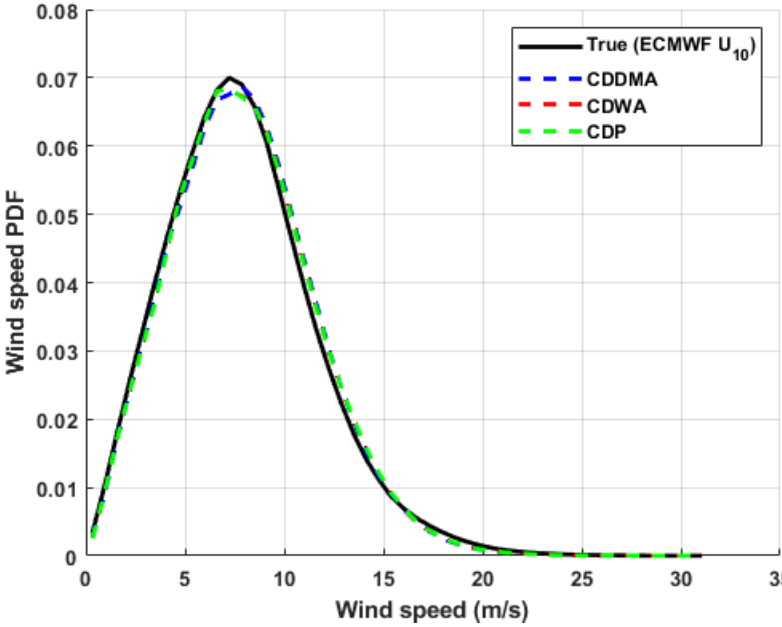
Figure 14. Probability density function (PDF) of reference winds (solid back) and retrieved winds using the proposed method with cDDMA (broken blue line), cDWA (broken red line), cDP (broken green line).